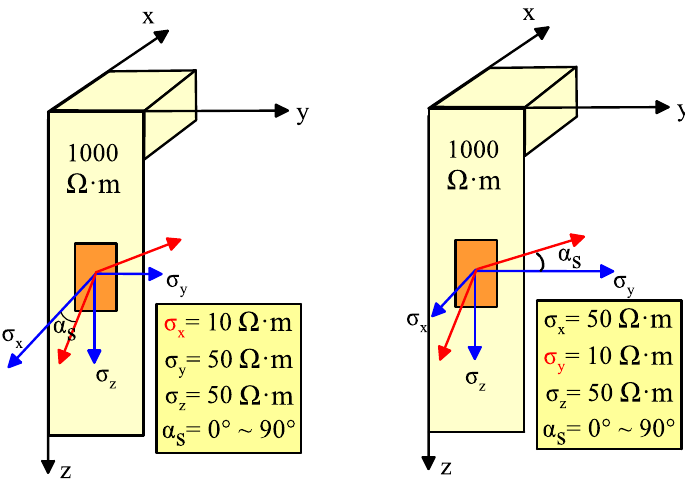
Figure 9. Fracture anisotropy model with strike variation.